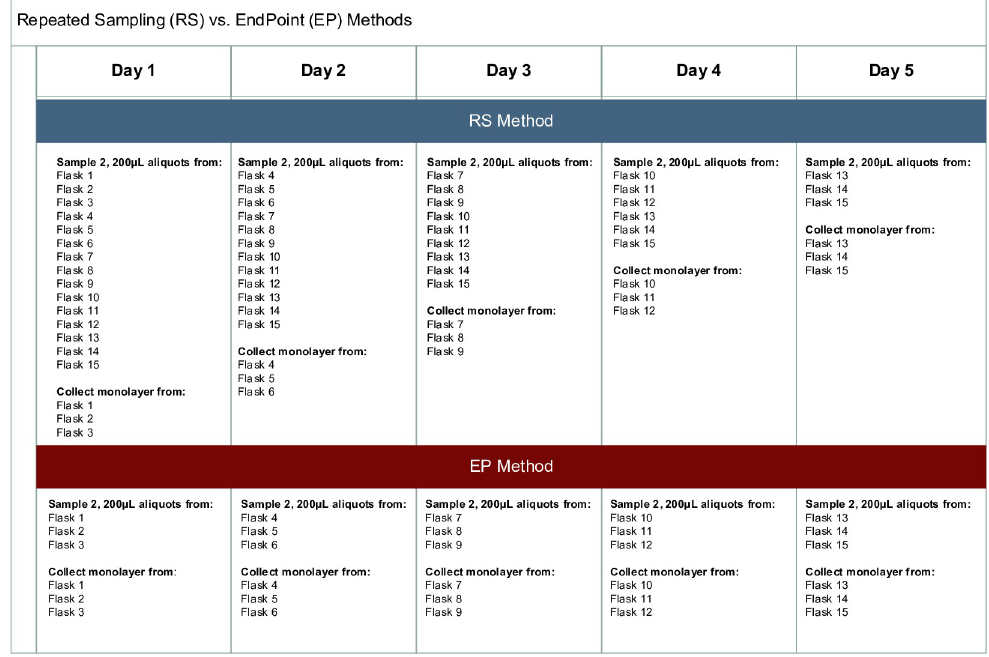
Fig 1. Repeated Sampling (RS) vs. Endpoint Method